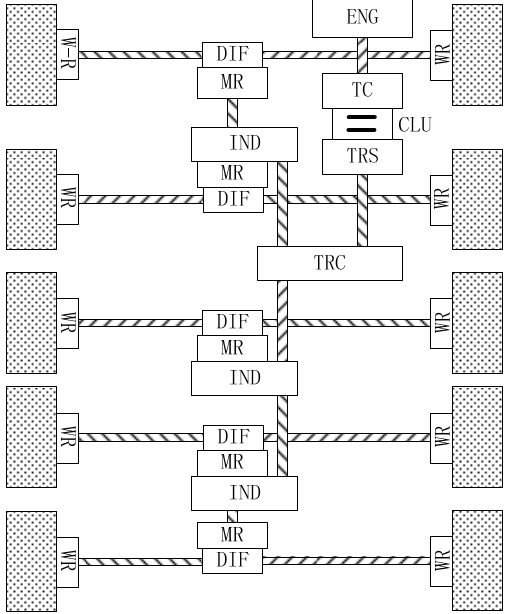
Figure 6. 5 ‐ axle vehicle’s powertrain system schematic diagram. Figure 6. 5-axle vehicle’s powertrain system schematic